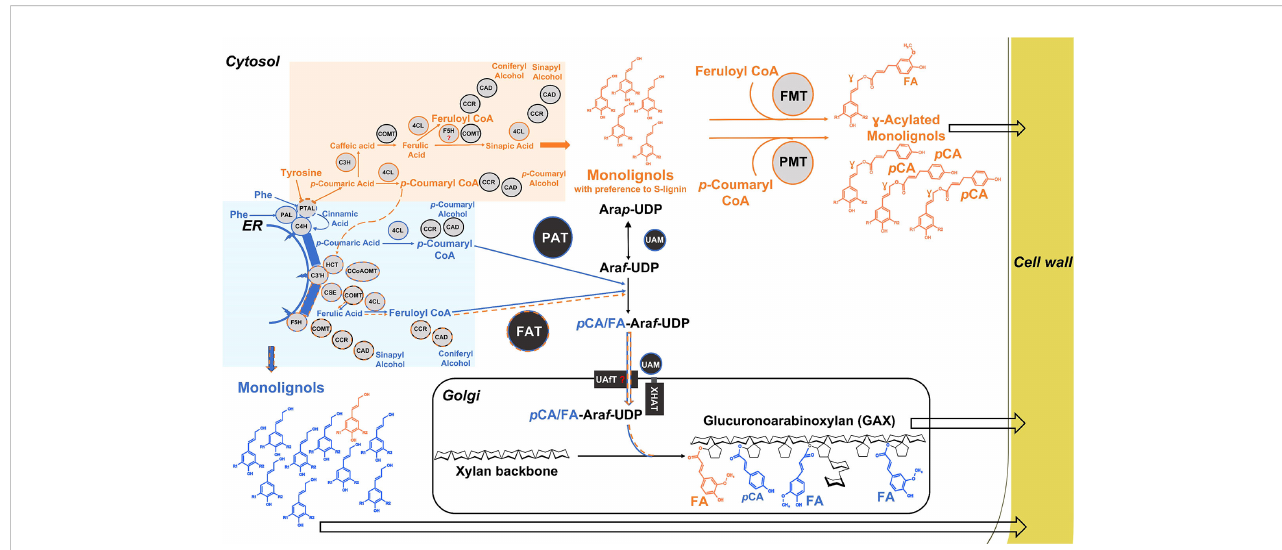
FIGURE 6 Model of hydroxycinnamoylation of lignin and GAX in grasses. The model shows putative pathways for the synthesis of HCAs and monolignols and their routes into the grass cell wall. The phenylalanine precursor-based primary phenylpropanoid pathway with early steps catalyzed by ER-localized enzymes is highlighted in blue and the orange color represents the tyrosine precursor-based pathway; some enzymes (4CL, CAD, CCR, COMT) are shared between these pathways but are shown separately for clarity. Dashed lines are our speculations. Question marks are added for the cytosolic F5H and UAfT as they have yet to be identi fi ed. g -acylated monolignols: S lignin – R1 = R2 = OMe, G lignin – R1 = OMe, R2 = H. Acyltransferases – PMT, p- Coumaryl CoA Monolignol Transferase, FMT, Feruloyl CoA Monolignol Transferase; PAT, p- Coumaryl CoA Arabinoxylan Transferase; FAT, Feruloyl CoA Ara f transferase; Lignin biosynthetic enzymes – PAL – monofunctional Phenylalanine Ammonia-Lyase, PTAL, bifunctional Phenylalanine/Tyrosine Ammonia-Lyase; C4H, Cinnamate 4-Hydroxylase; C3 ’ H - 4, Coumaroyl Shikimate/Quinate 3-Hydroxylase, HCT - Hydroxycinnamoyl CoA Shikimate/ Quinate Hydroxycinnamoyl Transferase, 4CL - 4-Coumarate : CoA Ligase, F5H1, Ferulate 5-Hydroxylase; C3H - bifunctional 4-Coumarate 3- Hydroxylase/Cytosolic Ascorbate Peroxidase, COMT - Caffeic Acid/5-Hydroxyferulic Acid 3/5-O-Methyltransferase, CSE, caffeoyl shikimate